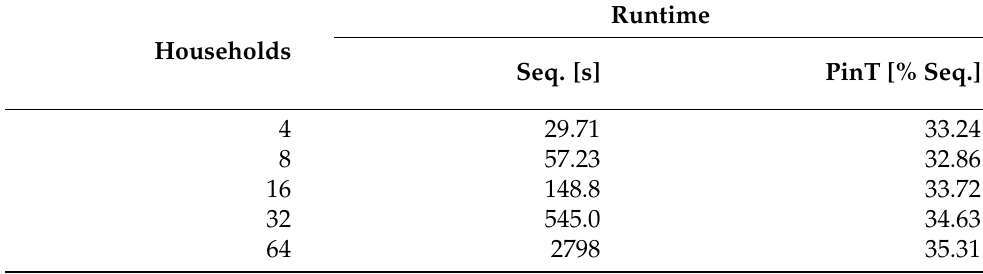
Table 5. Microgrid: Runtime Comparison Between PinT and Sequential Timestepping for Different Grid